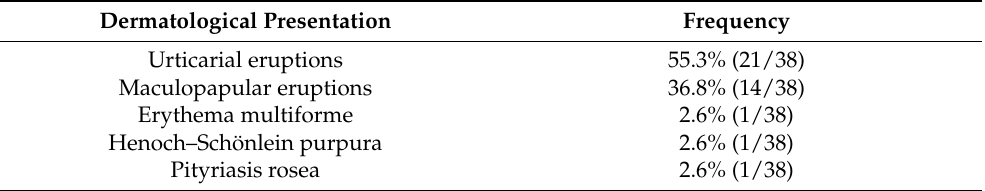
Table 2. Frequency of dermatological presentations of Mycoplasma-pneumoniae -induced cutaneous disease. Dermatological